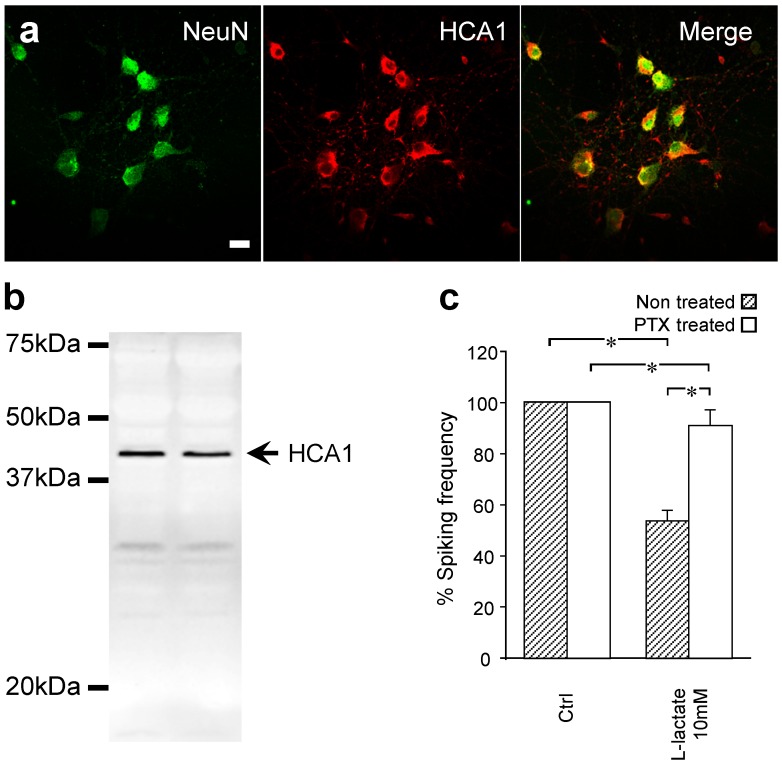
HCA1 receptor involvement in the lactate sensitivity.(a) Confocal images showing immunostaining for NeuN (green), HCA1 (red) and the merged image in mouse primary cortical neurons. Scale bar, 20 µm. (b) Representative Western blot showing that HCA1 is expressed in mouse primary cortical neuronal cultures. Each track represents one independent cultured dish of mouse primary cortical neurons (c) Comparison of lactate effect on calcium spiking frequency in cells incubated or not with pertussis toxin (PTX). PTX incubation strongly reduced the effects of lactate on neuronal activity. Data are obtained from 8 experiments and 61 cells for non-treated group and 8 experiments and 62 cells for PTX treated group.